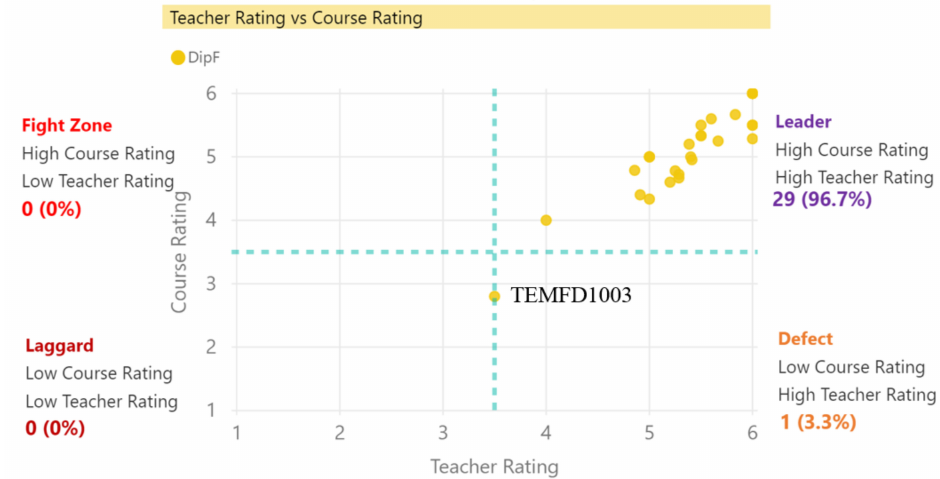
Figure 13. Teacher–Course Rating Matrix. Note: (1) In the visual, each data point represents the average course rate and rating given by students to a teacher for a particular